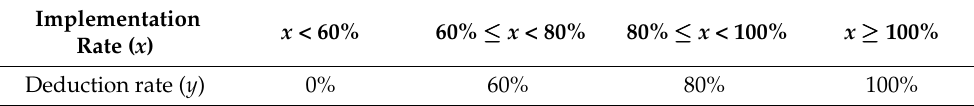
Table 3. The relationship between x and y in 6-h daily reduction model.